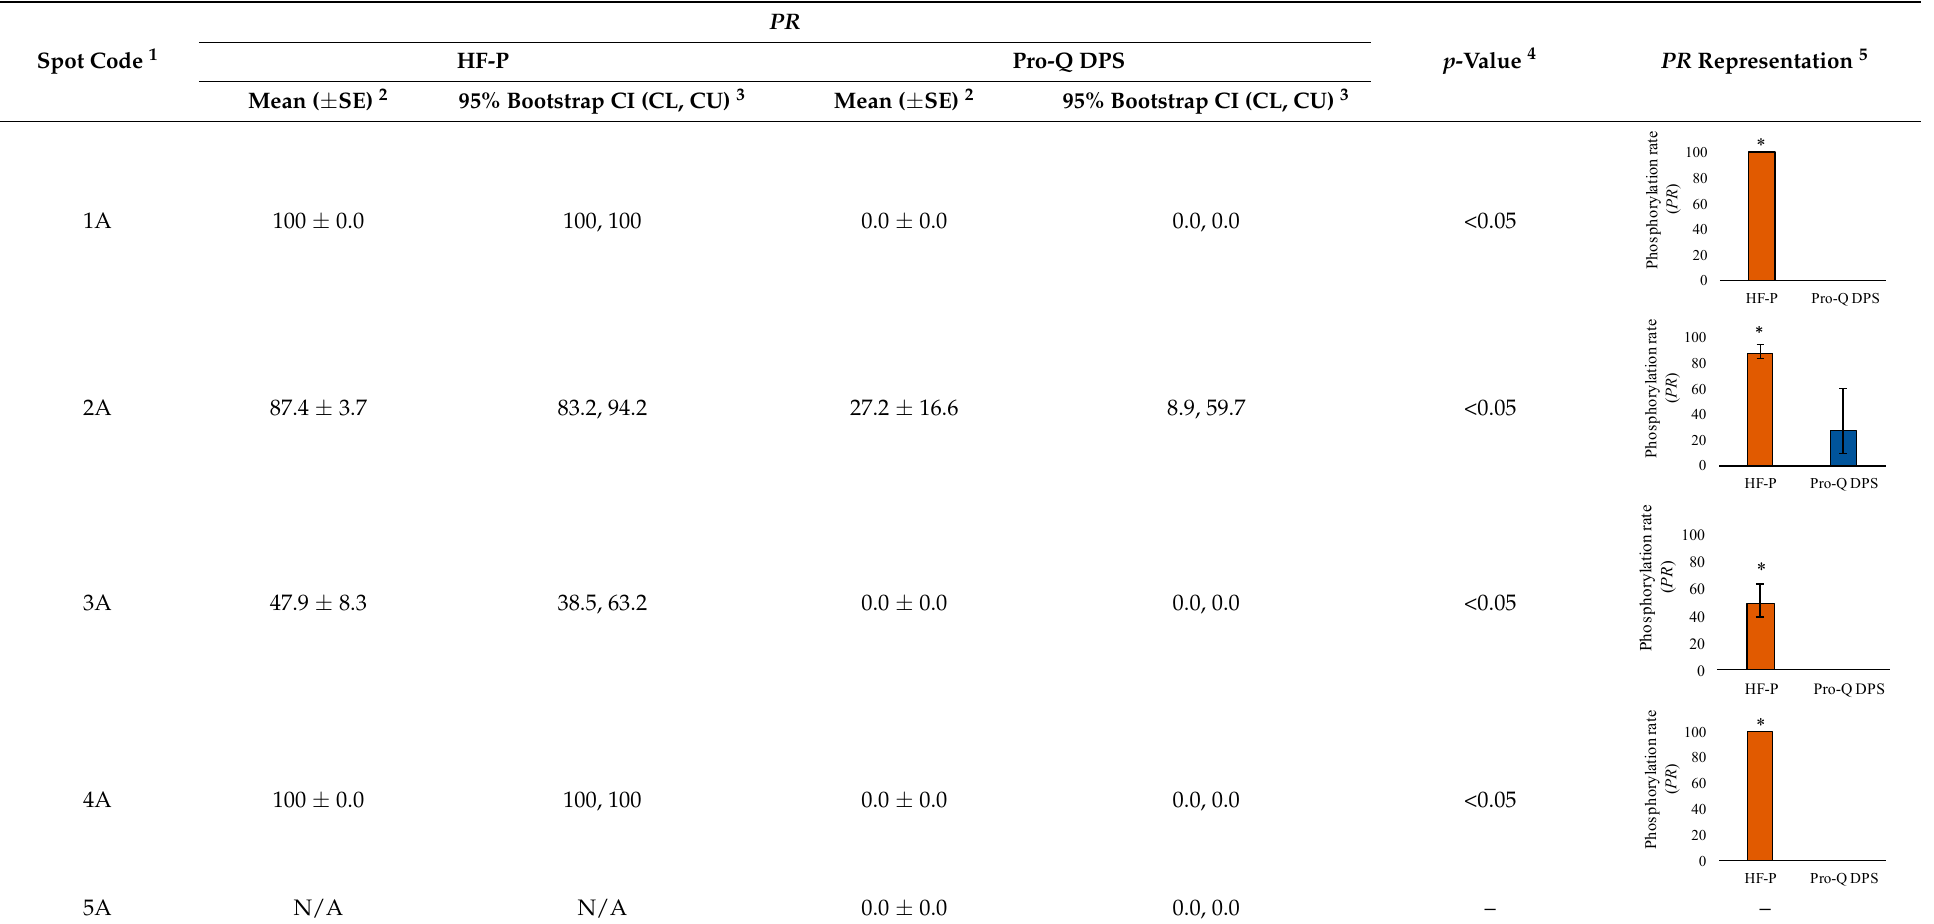
Table 2. Mean ( ± SE) of phosphorylation rate ( PR ) and its 95% CI for spots selected from three representative 2-DE gel zones obtained by HF-P and Pro-Q DPS methods. Table 2. Mean (±SE) of phosphorylation rate ( PR ) and its 95% CI for spots selected from three representative 2-DE gel zones obtained by HF-P and Pro-Q DPS Table 2. Mean (±SE) of phosphorylation rate ( PR ) and its 95% CI for spots selected from three representative 2-DE gel zones obtained by HF-P and Pro-Q DPS Table 2. Mean (±SE) of phosphorylation rate ( PR ) and its 95% CI for spots selected from three representative 2-DE gel zones obtained by HF-P and Pro-Q DPS Table 2. Mean (±SE) of phosphorylation rate ( PR ) and its 95% CI for spots selected from three representative 2-DE gel zones obtained by HF-P and Pro-Q DPS methods. methods. methods.